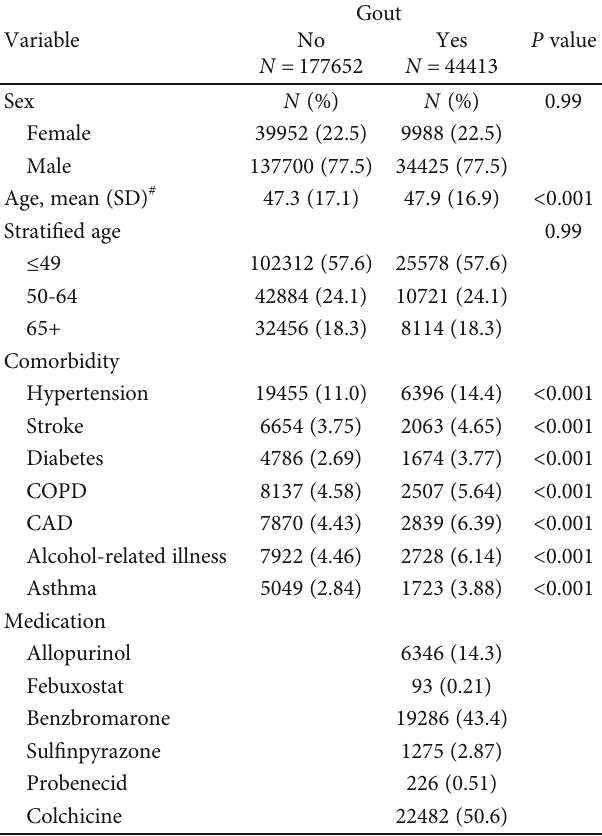
Table 2: Demographic characteristics, comorbidities, and medication in patients with and without gout.